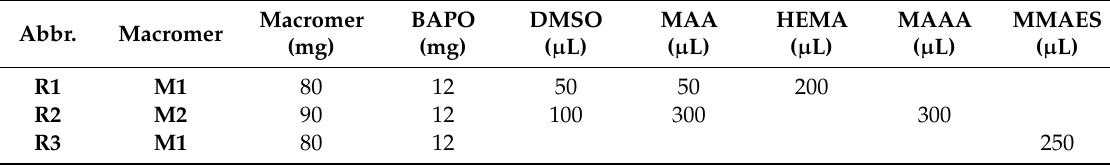
Table 2. Compositions of hydrogel resin solutions.